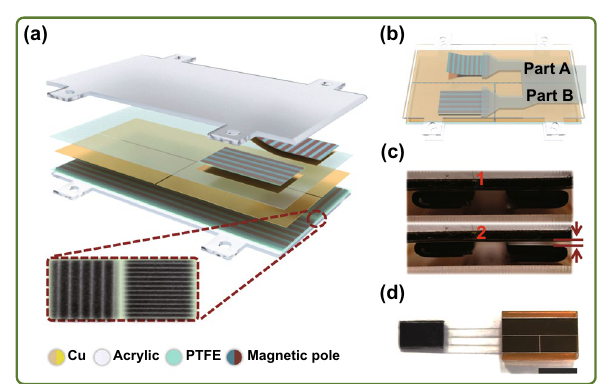
Fig. 1 Structure of the Ma-s-TS. a Schematic diagram and multilayer structure of the Ma-s-TS. The insets: developing photograph of the magnetic array on the substrate and slider. b Overall structure dia- gram. c Magnetic array assisted contact-separation state (top and bot- tom). d Photograph of an as-fabricated sensor (scale bar: 1